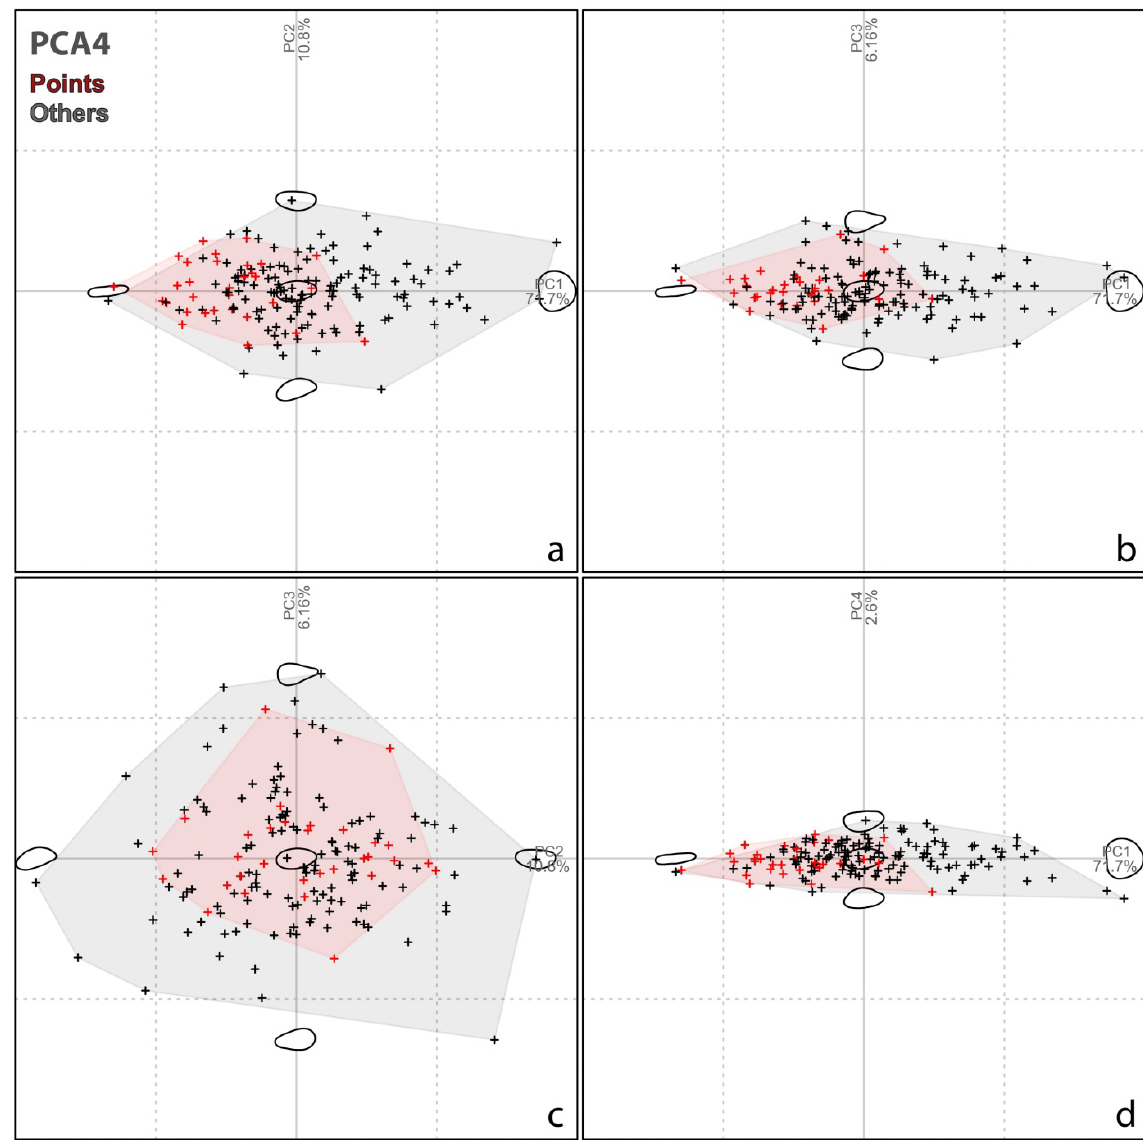
Figure 14. PCA4 - Plot of the PCA scores of the first four PCs. PCA is realised on EFA coefficients of the whole assemblages. Colours represent the categories: points are shown in red and the rest of the assemblage is in